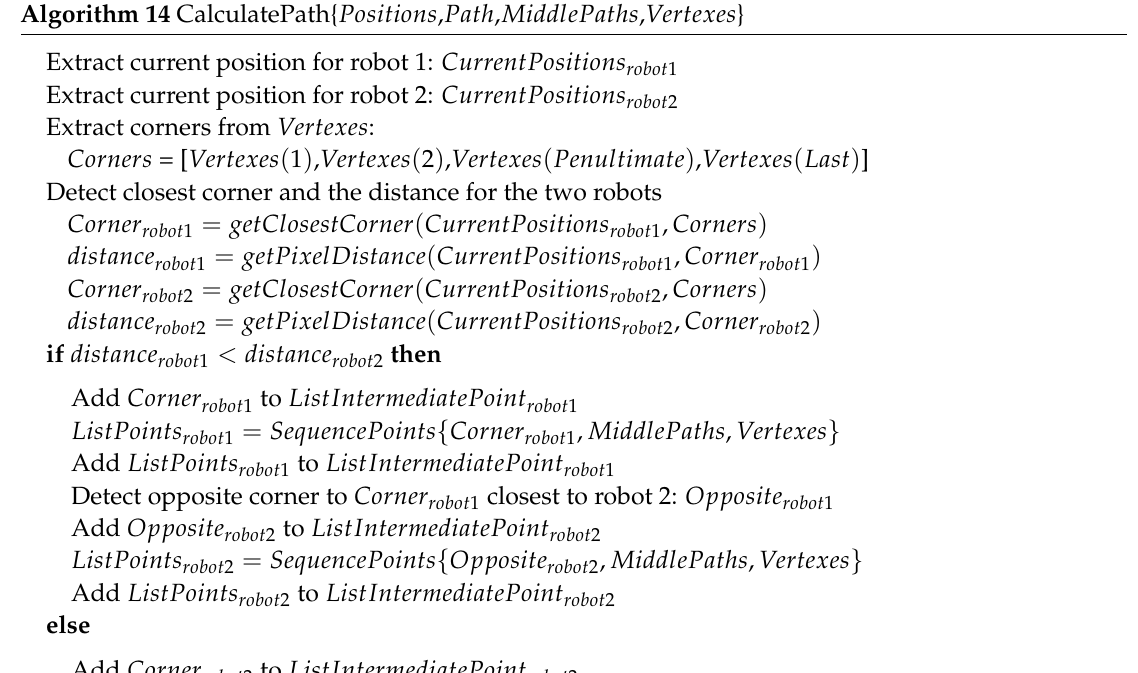
Algorithm 14 CalculatePath{ Positions , Path , MiddlePaths , Vertexes